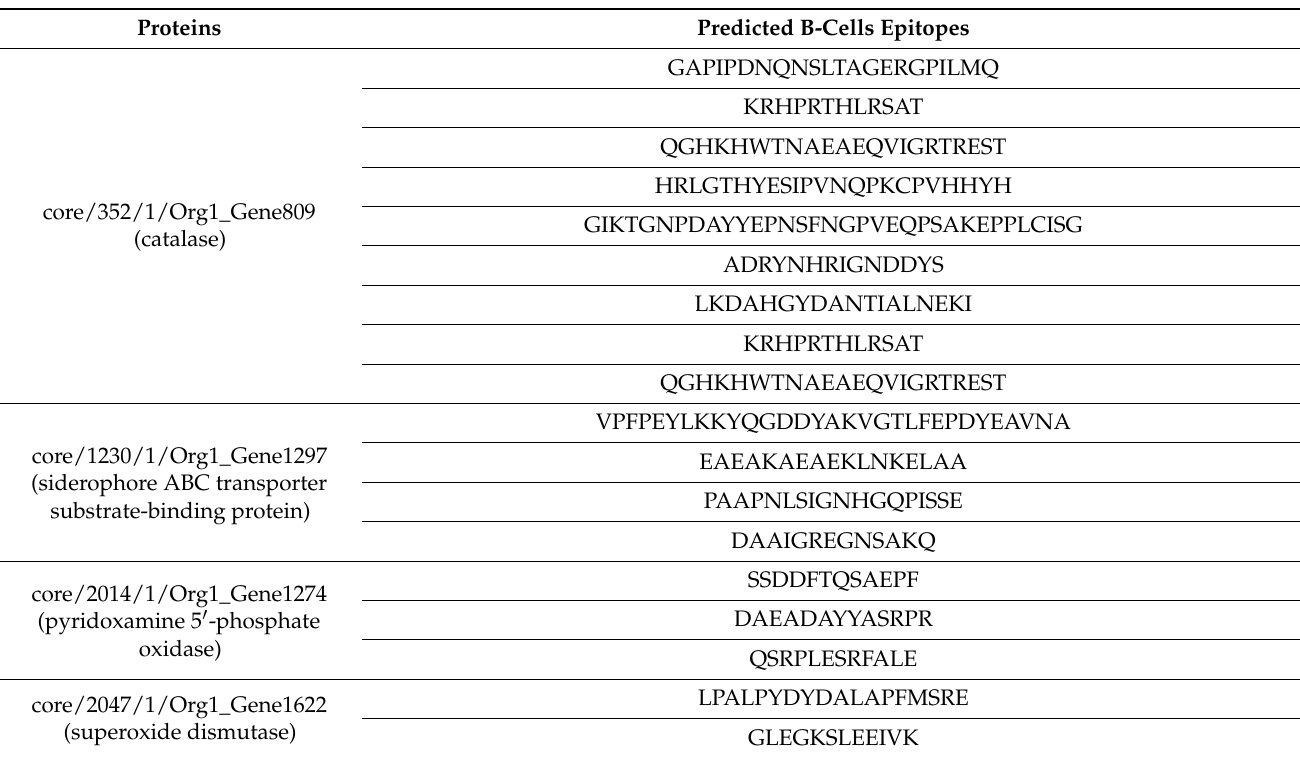
Table 1. Predicted B-cells epitopes. The epitopes vary in length and have higher scores than the